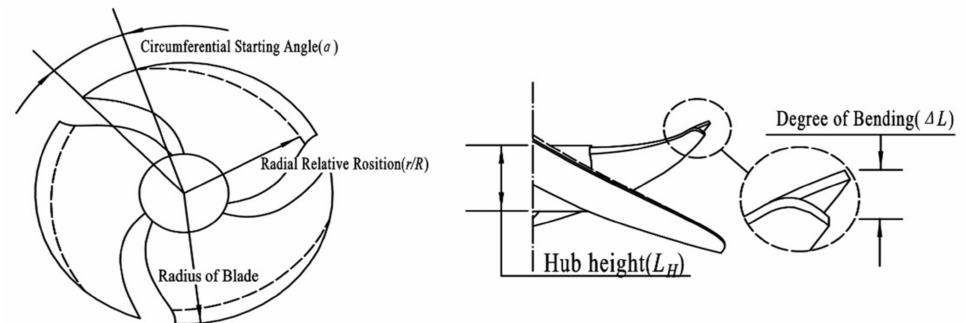
Figure 2. Original blade model.